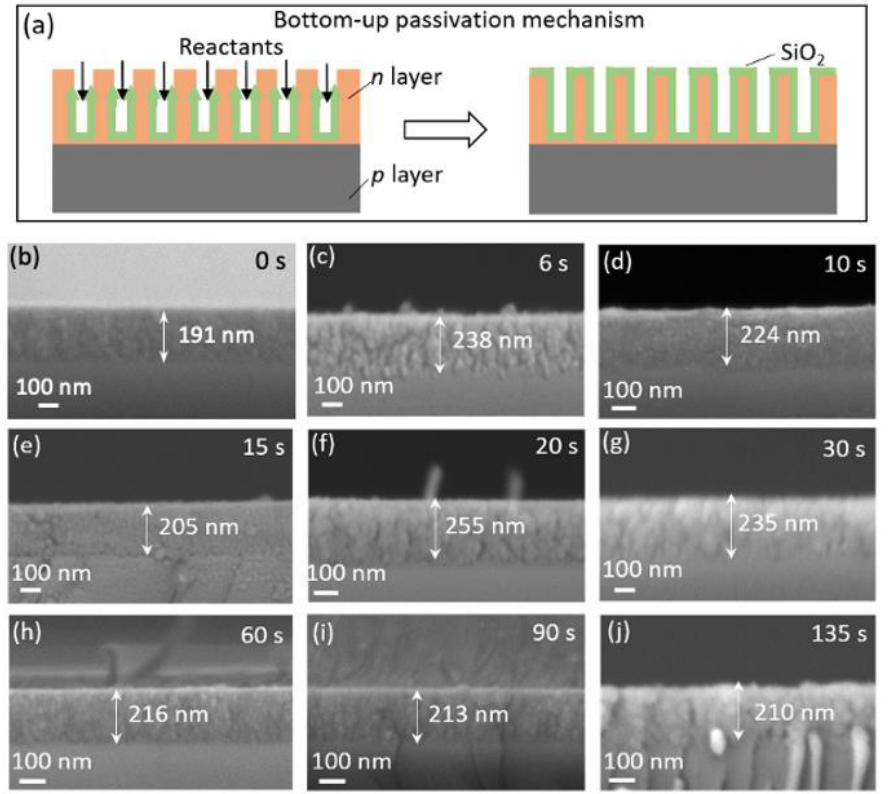
Figure 5. ( a ) Schematic of the bottom-up anodization process of SiO 2 passivated PS-2 layer; ( b – j ) cross-sectional SEM images of fabricated PS-2 layers of different thickness (191–255 nm).